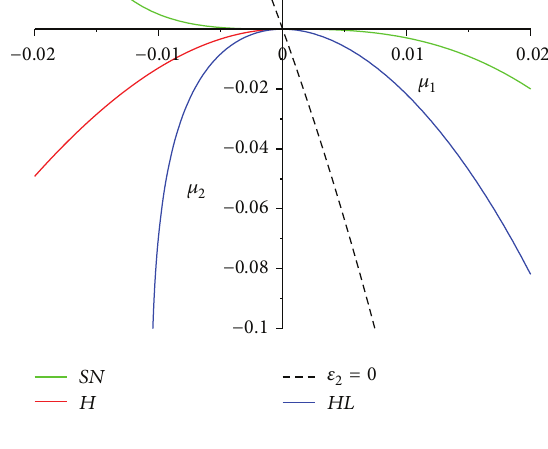
Figure 1: (a) System (4) shows an unstable limit cycle when 𝑎 = 1.6 , 𝛽 = 2 , 𝑚 = 0.13095 , and ℎ = 0.128 . 𝛿 2 ≈ 0.2220 > 𝛿 = 0.00249 > 0.00235 ; (b) System (4) shows a stable limit cycle when 𝑎 = 1.2 , 𝛽 = 2 , 𝑚 = 0.08235 , and ℎ = 0.08396 . 𝛿 0.003639 .